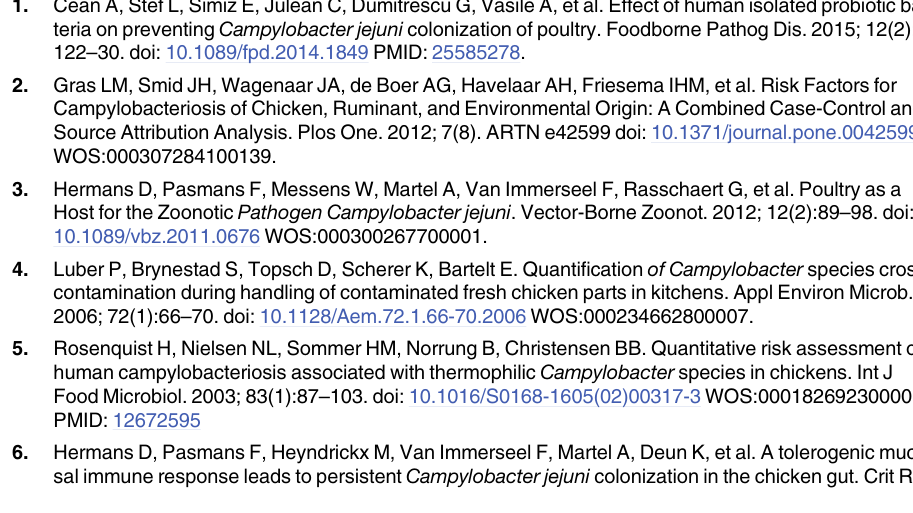
S1 Table. Relative abundance of each taxonomic unit found within each individual chicken